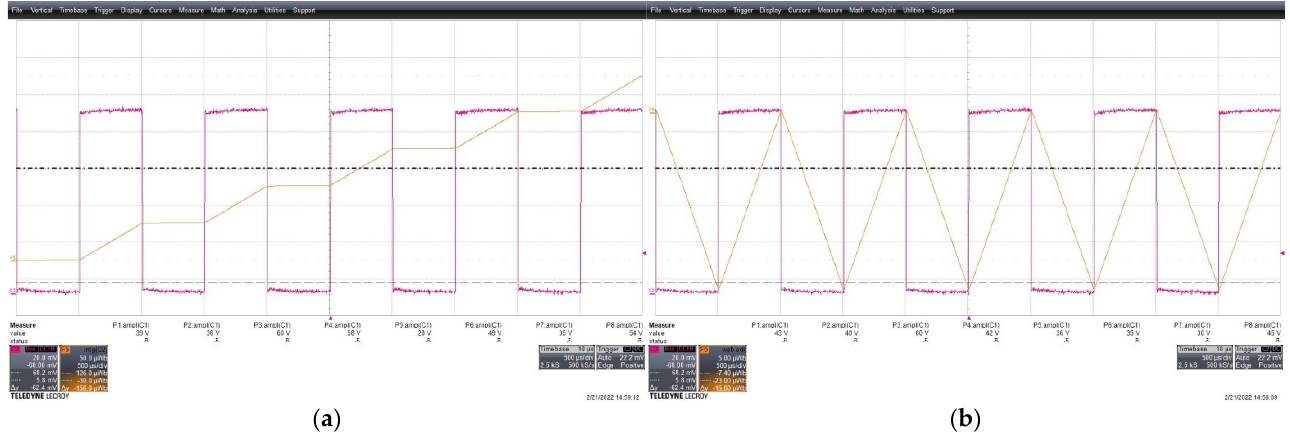
Figure 2. Rectangular waveform integration process, ( a ) signal non-zero mean value (purple), integral signal (yellow), ( b ) signal with mean value extracted (purple), integral signal (yellow).